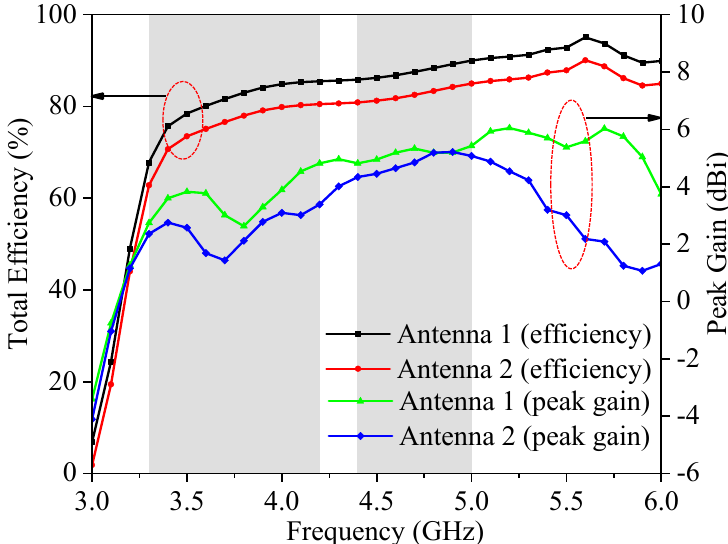
Figure 14. Measured peak gain and total efficiency of the designed antenna.